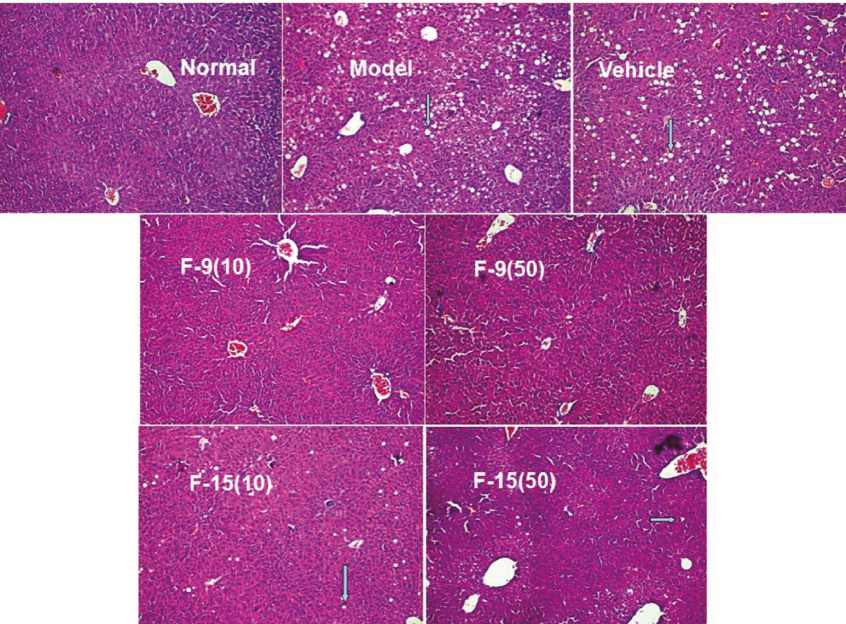
Figure 5: H&E staining of the mouse liver of model (model group) and vehicle (vehicle group). F-9 (10) (F-9, 10 mg/kg), F-9 (50) (F-9, 50mg/kg), F-15 (10) (F-15, 10mg/kg), and F-15 (50) (F-15,